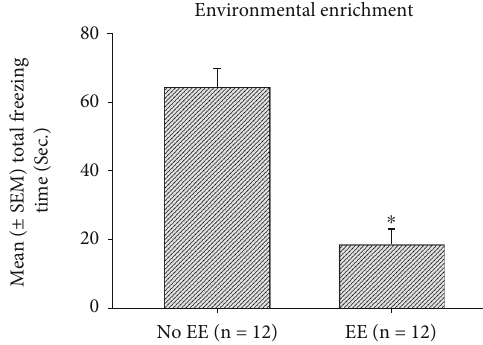
Figure 2: Assessments of the mean ( ± SEM) total freezing time (Sec.) for the min e ff ect of EE in the no EE ( n = 12 ) and EE ( n = 12 ) conditions. EE: environmental enrichment. ∗ p < 0 : 05 indicates signi fi cant di ff erences compared to the no EE condition.